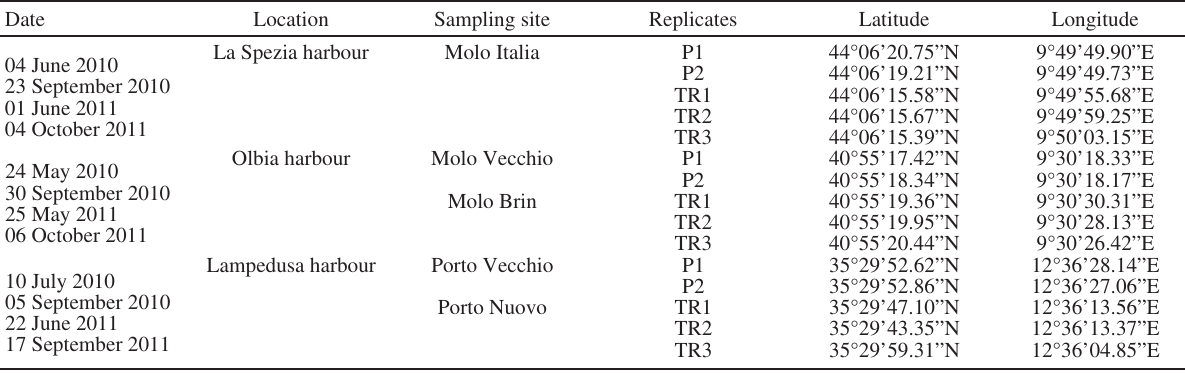
Table 1. – Details of sample collection where Celleporaria brunnea was found. P, replicates collected at the residential mooring area; TR, replicates collected at the transit mooring area. Location Sampling site